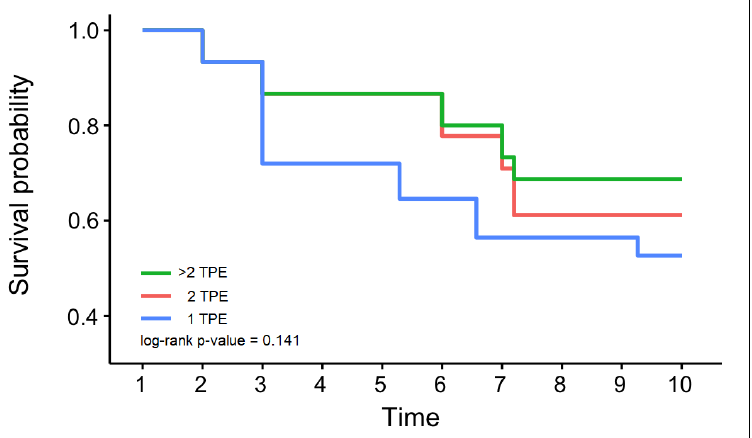
Figure 2. Kaplan – Meier survival analysis by number of TPE sessions. Time was measured in days. Figure 2. Kaplan–Meier survival analysis by number of TPE sessions. Time was measured in